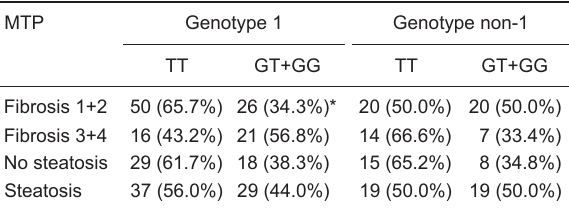
Table 4. Allele frequencies of the MTP -493G/T polymorphism in chronic hepatitis C patients according to steatosis and fibrosis grades and according to viral genotypes.